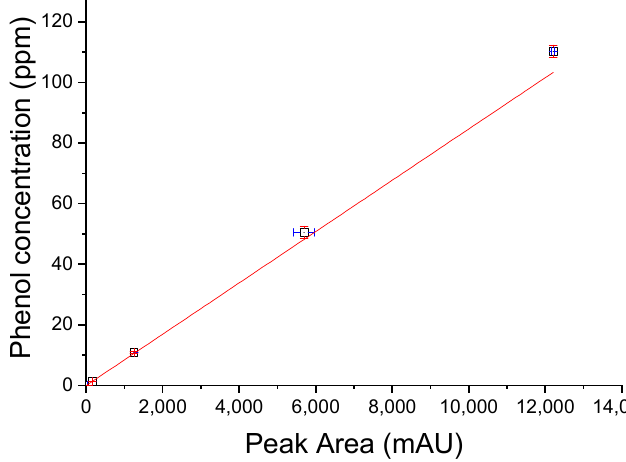
Figure 1. Phenol HPLC calibration curve.